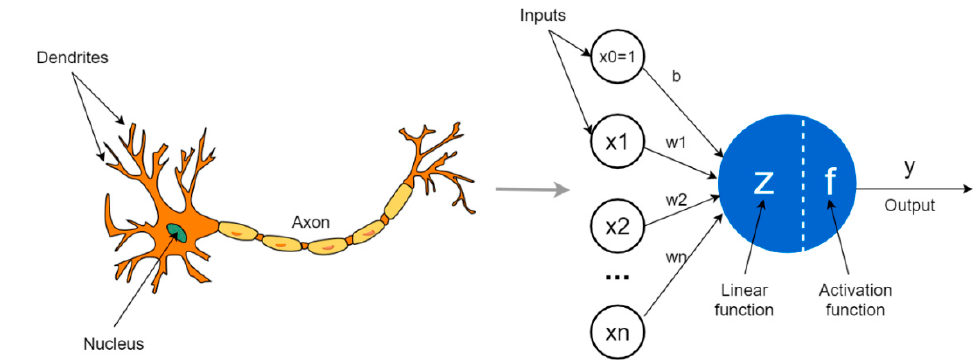
Figure 1. Schematic model of the perceptron and its similarity to the structure of a neuron [24].